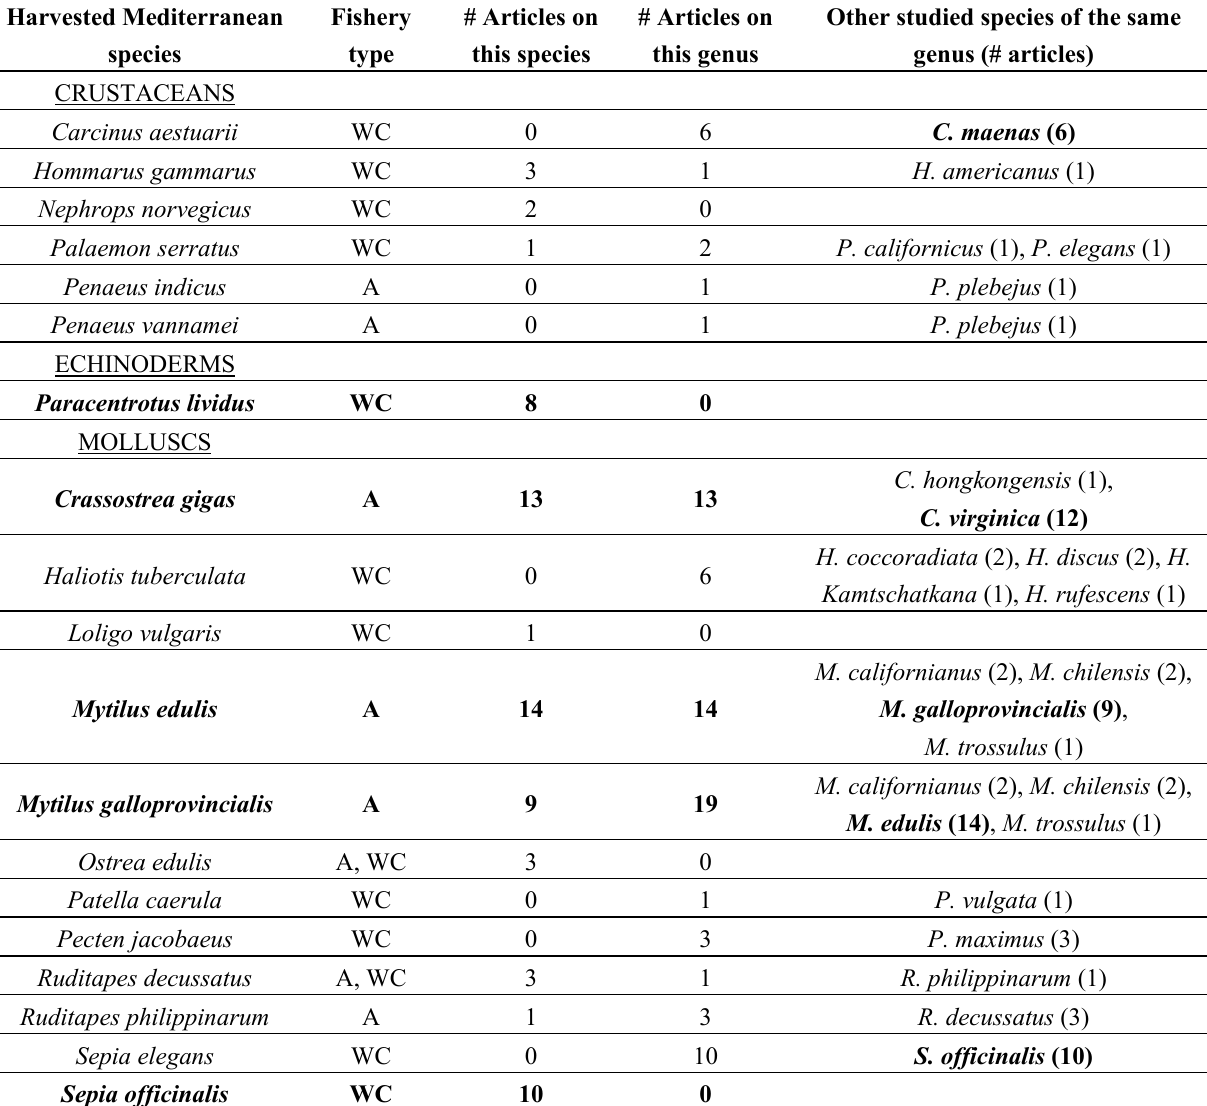
Table 1. Harvested species and the number of articles about this species or genus (A = aquaculture, WC = wild catch). Bold species names highlight those with more than three